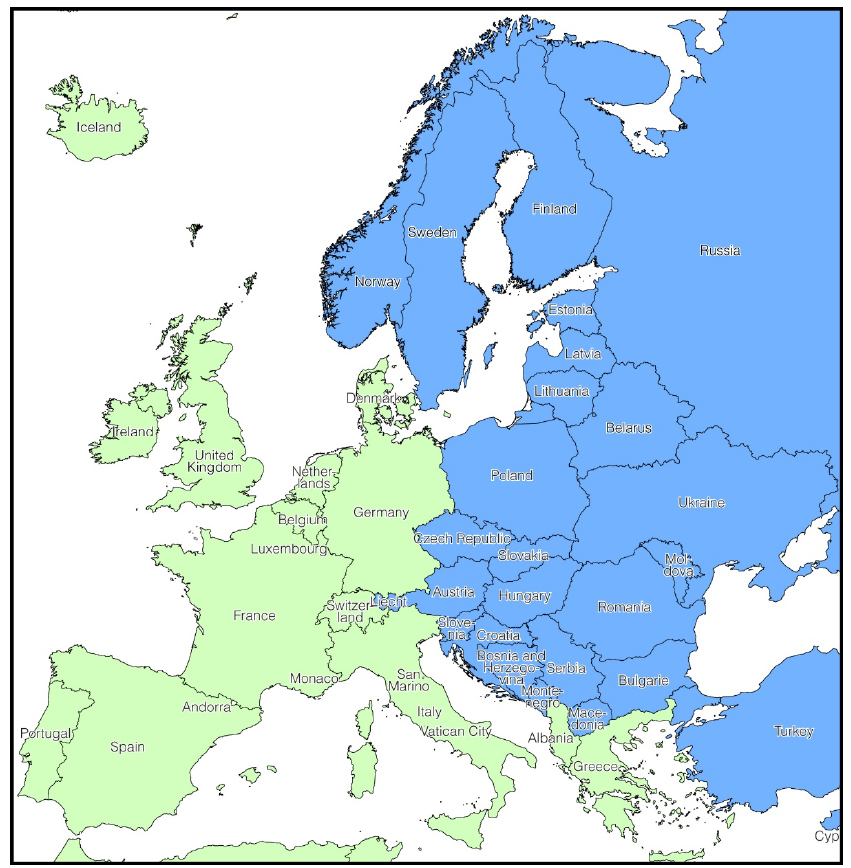
Figure 1. Map of Europe divided by Köppen Climate Classification. Blue part—Eastern Europe; Green part—Western Europe.